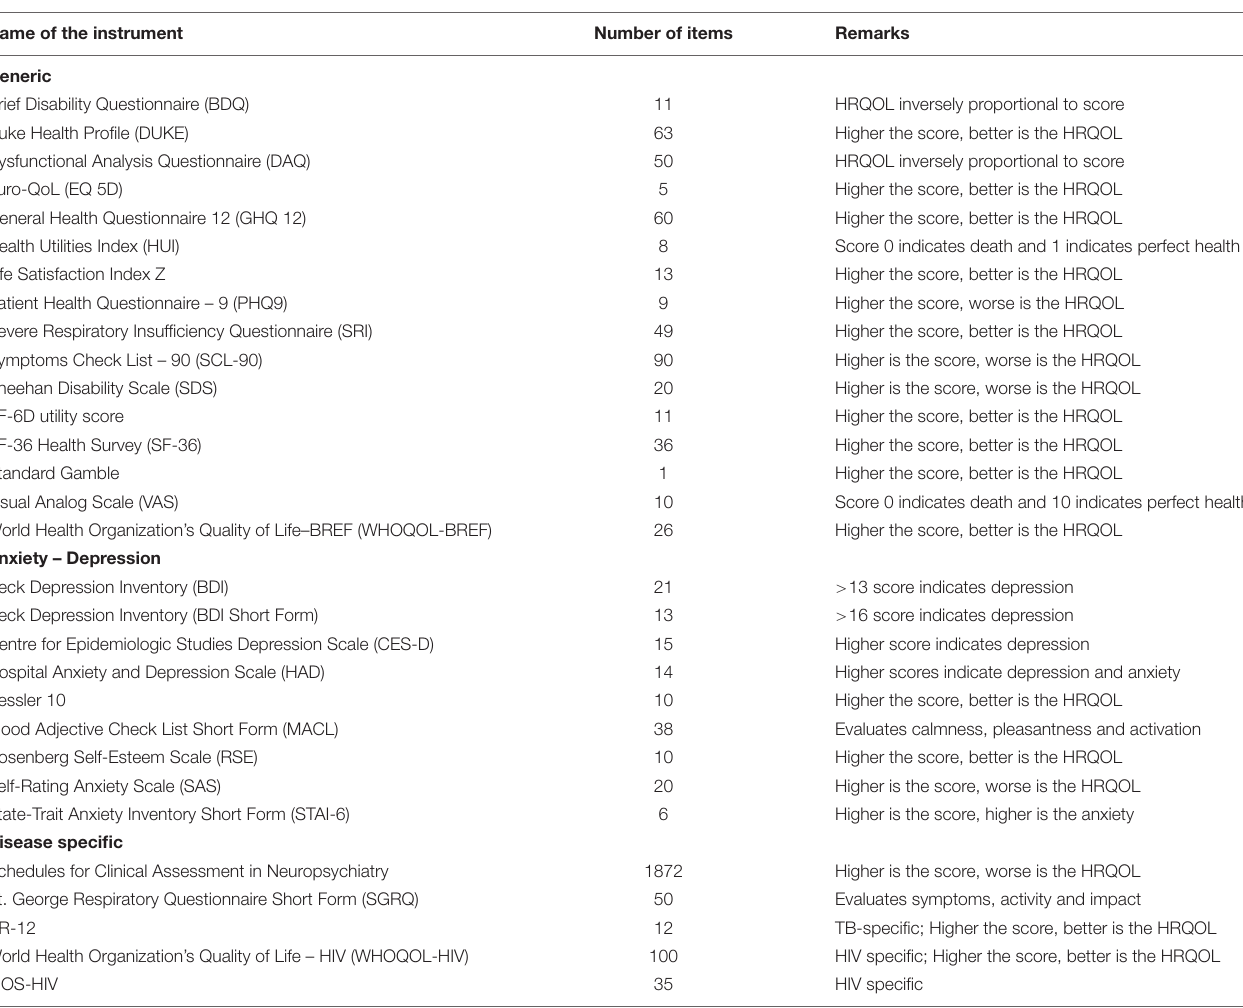
TABLE 1 | Salient features of instruments used to measure HRQOL in TB